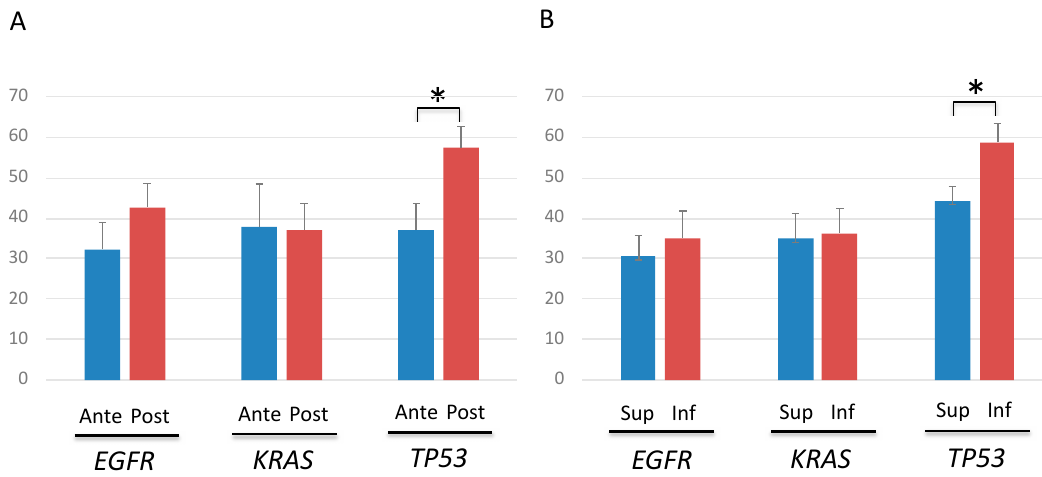
Figure 5. Allele fraction (AF) of TP53, EGFR and KRAS mutations according to the cancer location. ( A ) Comparison of AFs between tumors located at the ventral and dorsal sides showed significantly higher AFs only in tumor protein p53 ( TP53 )-mutated tumors located at the dorsal side. Blue and red lines denote anteriorly-, and posteriorly-located cancers, respectively. * p < 0.05. ( B ) Comparison of AFs between tumors located at the cranial and caudal sides showed significantly higher AFs only in TP53 -mutated tumors located at the caudal side. Blue and red lines denote superiorly- and inferiorly-located cancers, respectively. * p < 0.05.